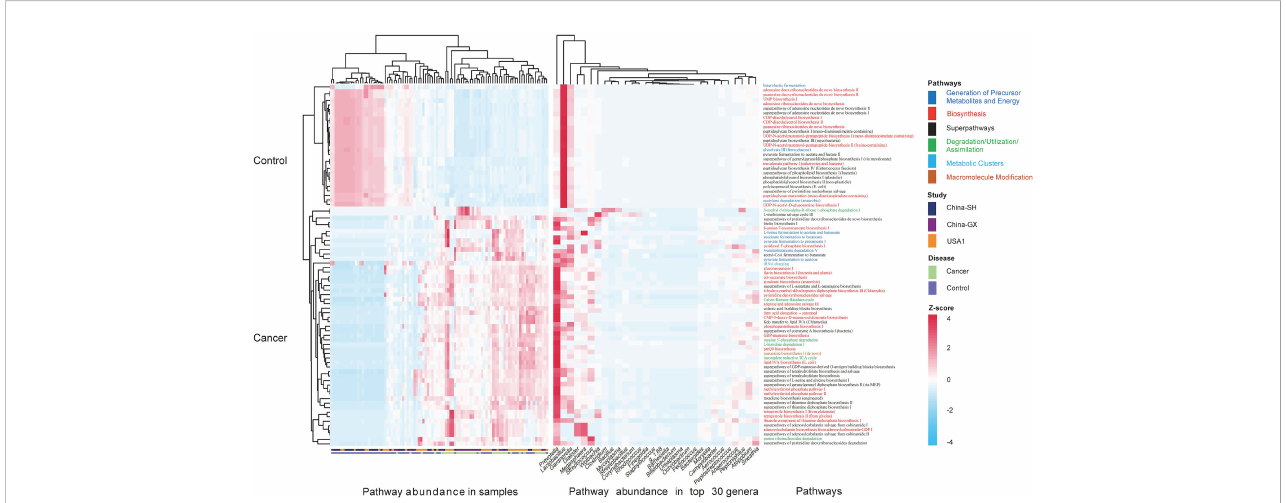
FIGURE 7 The contributions of the top 30 genera to the differential functional pathways. Heatmap showed the differential functional abundances in cervical cancer and controls ( P <0.05), and the contributions of the top 30 genera to the pathway abundances. The z-score of each genus to each pathway was indicated in the heatmap. A positive z-score means that the pathway by the genus contributes to its relative increase in cervical cancer, whereas a negative z-score means the pathway by the genus contributes to its decrease in cervical